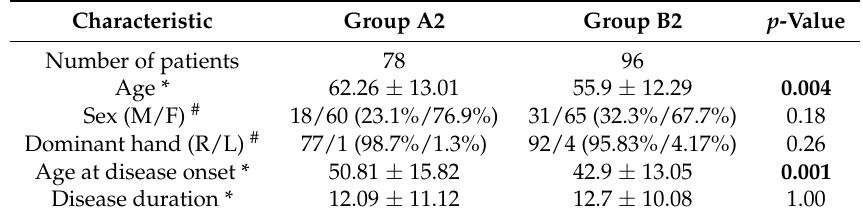
Table 2. Clinical and demographic characteristics of the patients belonging to groups A2 and B2 (statistically significant p -values ( p < 0.05) are highlighted with bold font). Characteristic Group